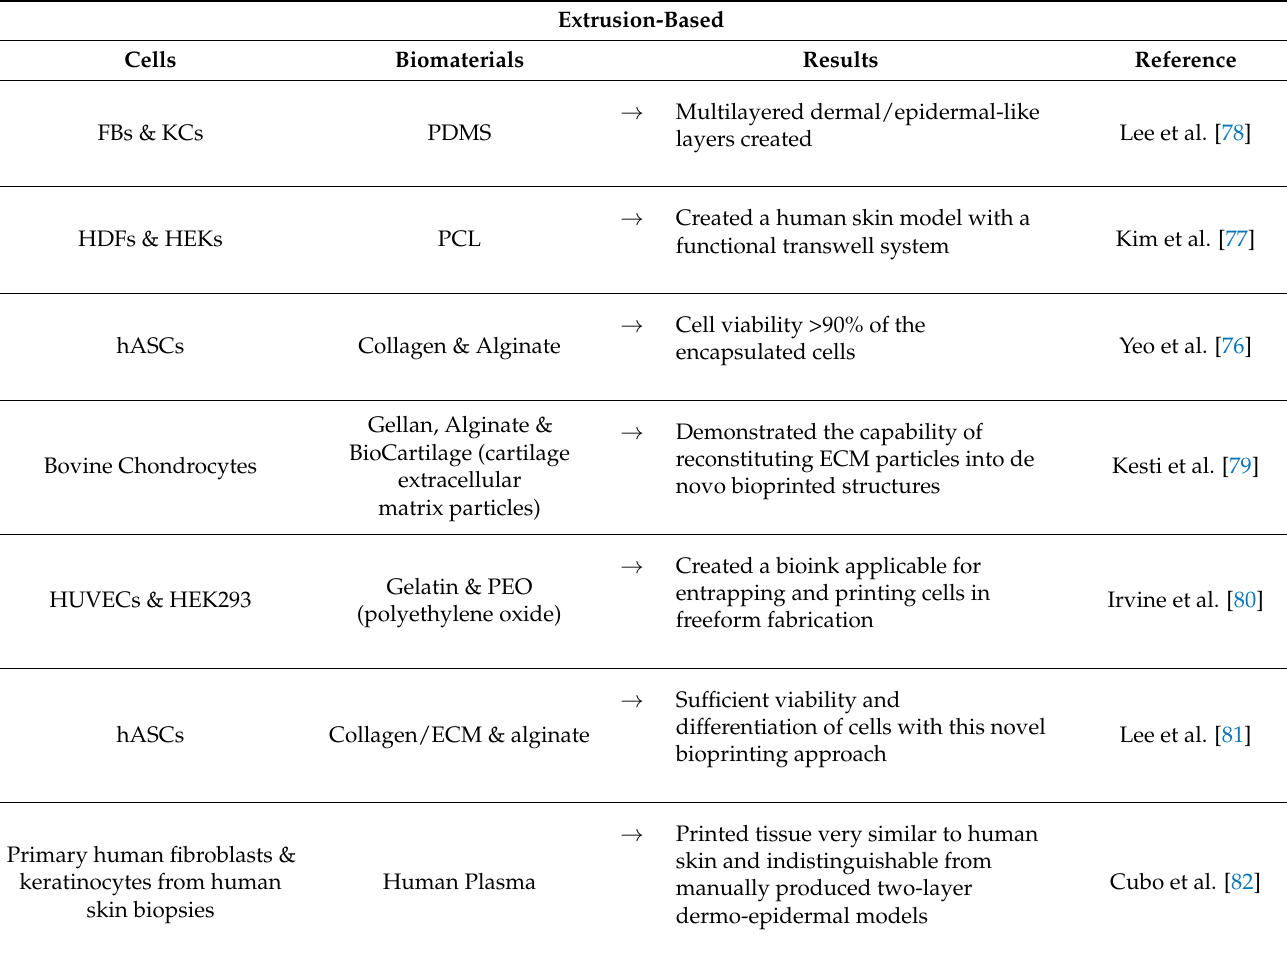
Table 2. Extrusion-based printing technologies in tissue engineering: Overview of recent study results. FB: fibroblast; KC: keratinocyte; PDMS: poly(dimethylsiloxane); HDF: human primary dermal fibroblasts; HEK: human primary epidermal keratinocytes; PCL: polycaprolactone; hASC: human adipose stem cells; ECM: extracellular